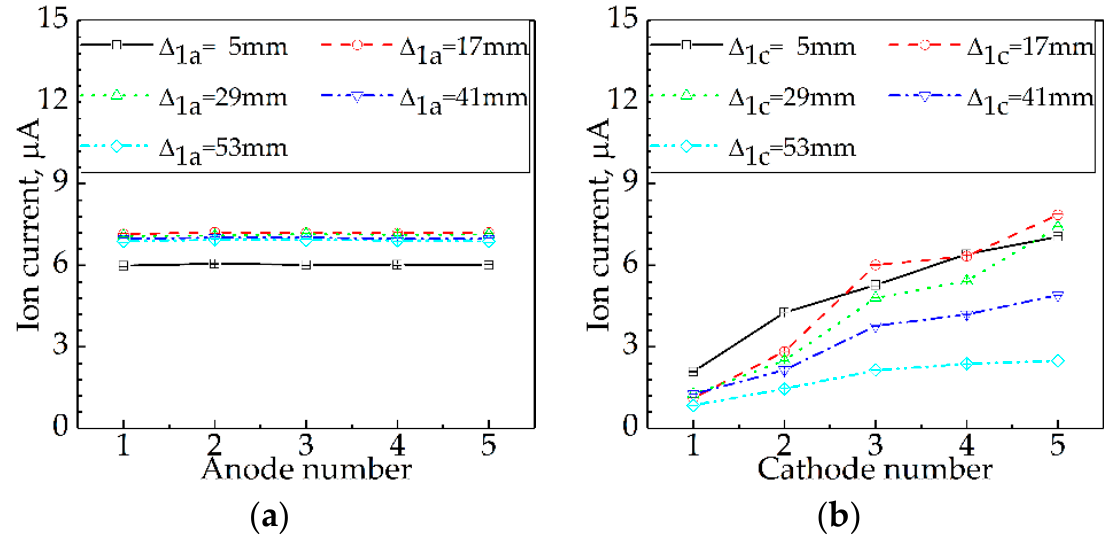
Δ = 5–65 mm: ( a ) effect of Figure 5. Effect of S e on I at ∆ 1 = 5–65 mm: ( a ) effect of S a on I ; ( b ) effect of S c on I S on I at Figure 5. Effect of e 1 Table 4. Experimental conditions for Factor 2.